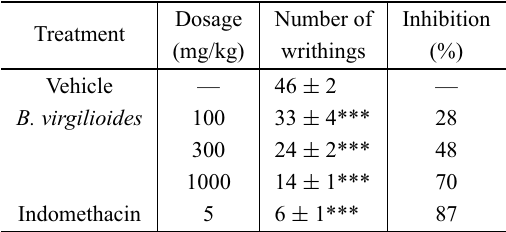
Effect of orally administered ethanolic extract of Bowdichia virgilioides on nociception induced by acetic acid in mice. Dosage Number of Inhibition Treatment (mg/kg) writhings (%)